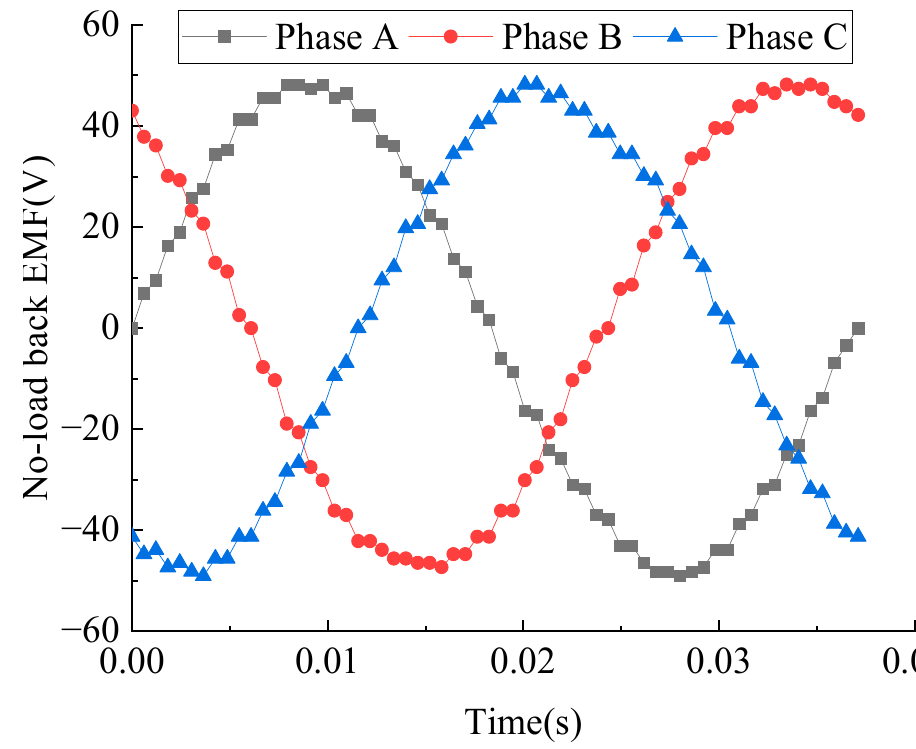
Figure 22. STMLPMVG no-load back EMF.